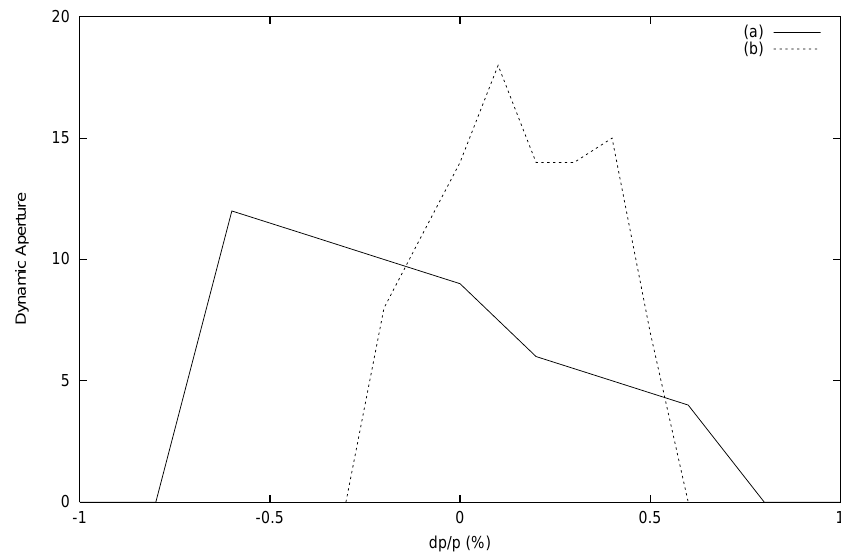
FIG. 47. Example (a): A preliminary dynamic aperture for the 4 cm b (cid:1) mode where s rms (cid:1) 82 m m (solid line) and the 14 cm b (cid:1) mode where s rms (cid:1) 281 m m (dashed line).